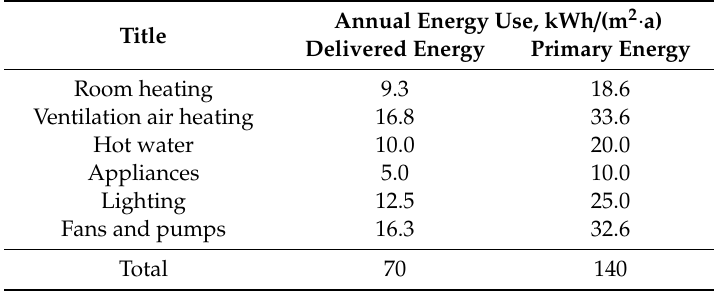
Table 4. Calculated annual delivered and primary energy for BC with GSHP.